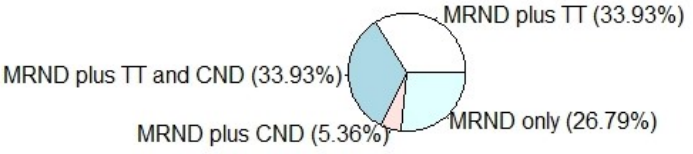
Figure 2. Pie chart showing the surgical procedures carried out in the series. Surgeries were classified as: 19 (33.93%) Modified Radical Neck Dissection (MRND) plus Total Thyroidectomy (TT), 19 (33.93%) MRND plus TT and Central Neck Dissection (CND), 3 (5.36%) MRND plus CND, 15 (26.79%) MRND only.